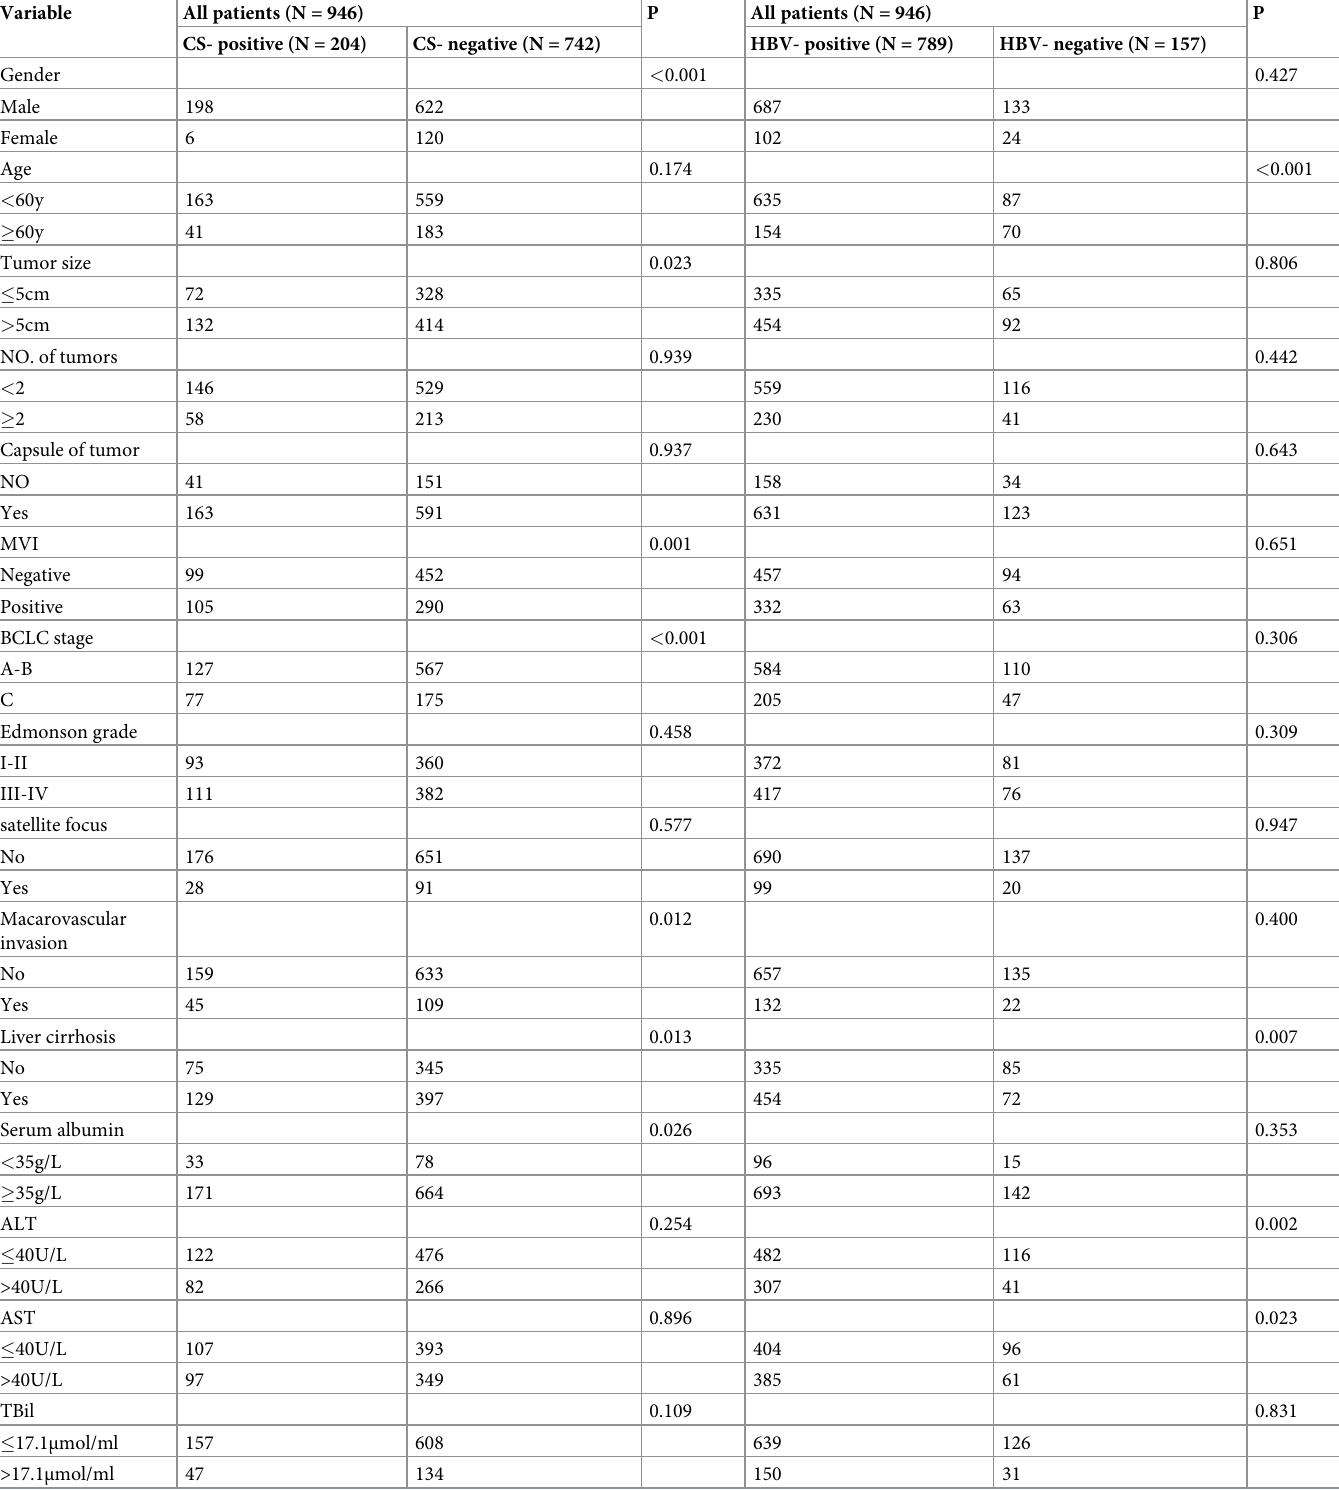
Table 1. Clinicopathology of patients with hepatocellular carcinoma treated by hepatic